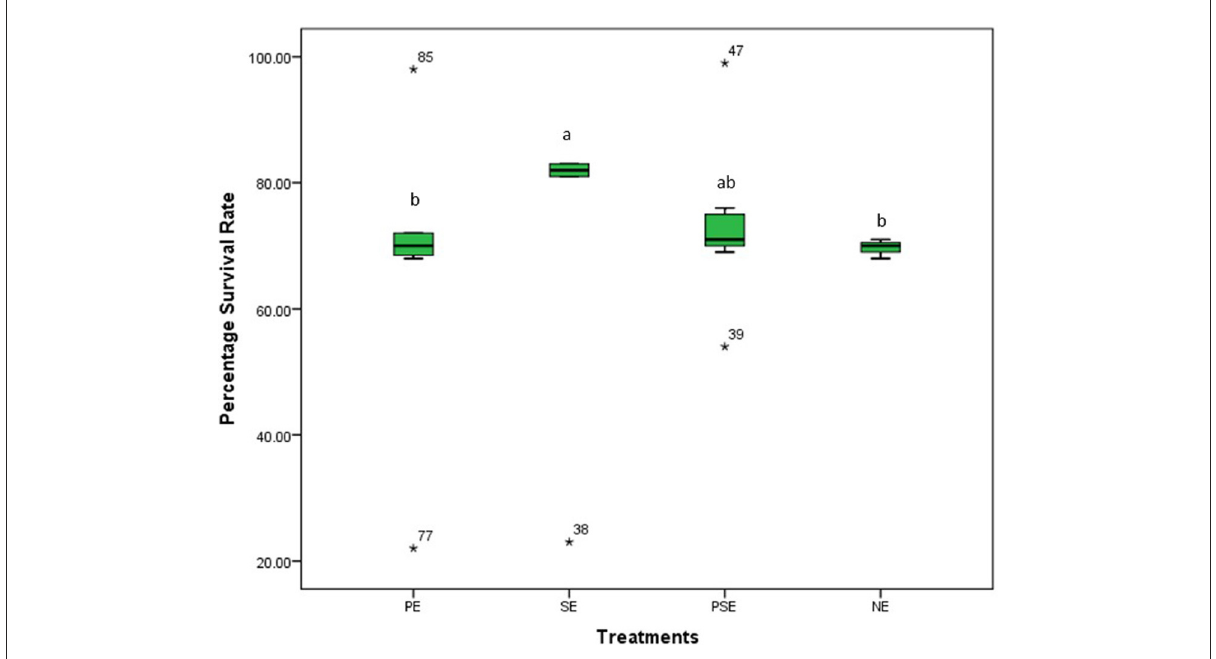
FIGURE1 The survival rates of Clarias gariepinus exposed to plant enriched (PE), substratum enriched (SE), plant and substratum enriched (PSE) and non-enriched (NE) culture tanks. A significant difference between treatments was indicated with different letters at p < 0.05.